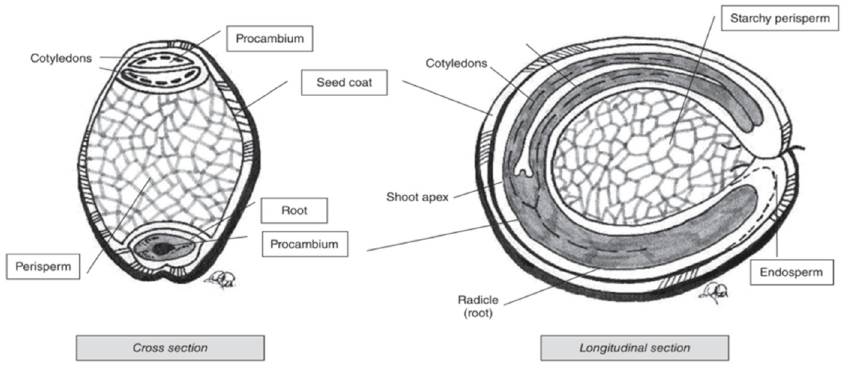
Figure 4. Cross and longitudinal section of amaranth seed [76].